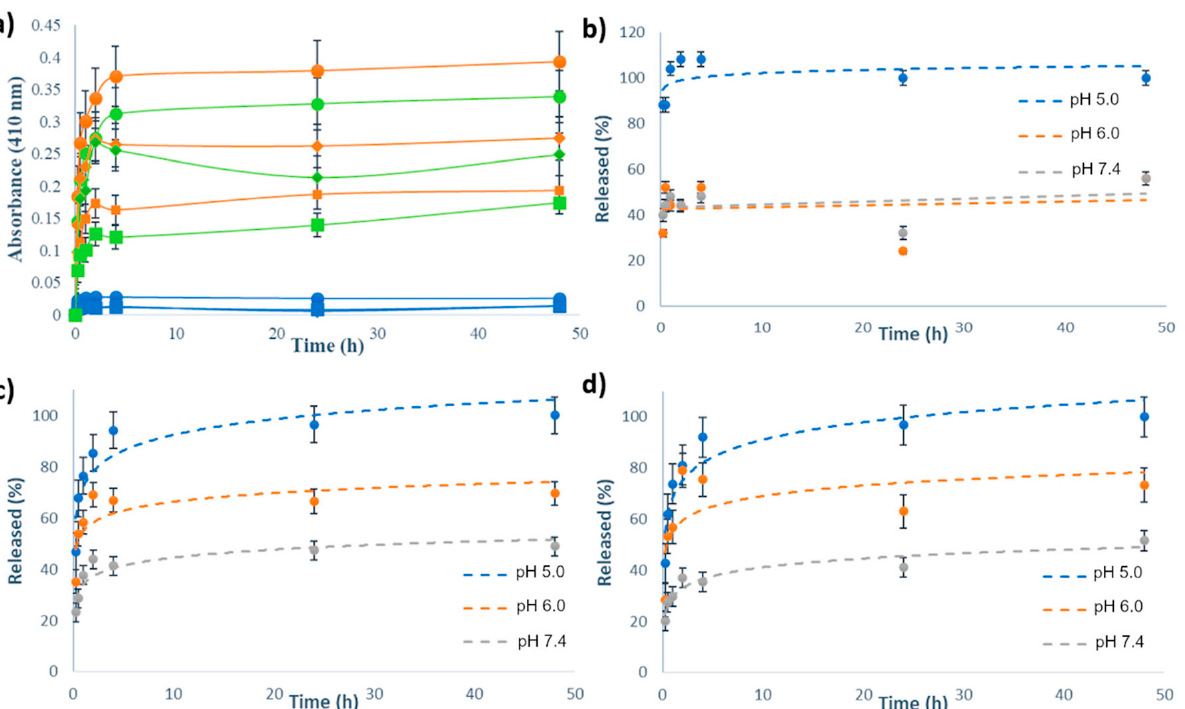
Figure 4. ( a ) Release profiles of Ru(II)-based complexes from MSN-H1[Ru] (orange curves), MSN-H2[Ru] (green curves) and MSN[Ru] (blue curves) in PBS buffers with pH 5.0 ( • ), pH 6.0 ( (cid:7) ) and pH 7.4 ( (cid:4) ) for 48 h, as measured by UV/VIS spectrophotometry at 410 nm; Release kinetics of ( b ) MSN[Ru]; ( c ) MSN-H1[Ru] and ( d ) MSN-H2[Ru] in PBS buffers with various pH values for 48 h, as measured by UV/VIS spectrophotometry at 410 nm, with absorbance values normalized to the absorbance of the supernatant from the same type of the material at 48 h and pH